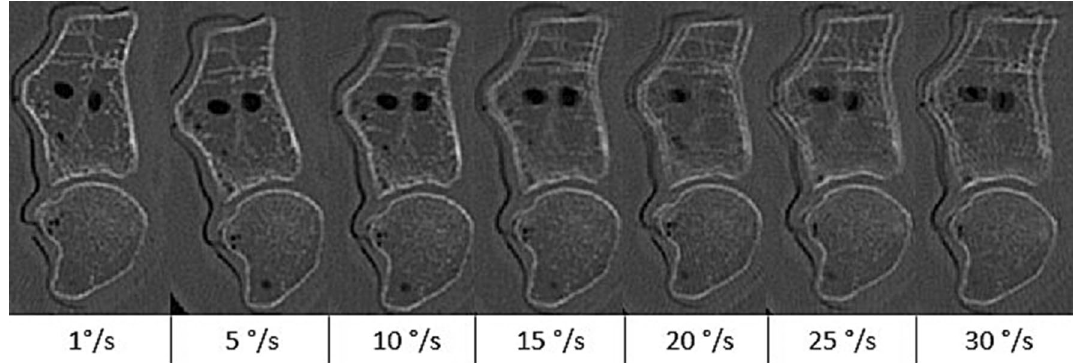
Figure 7. Target frame motion artefacts: CT target images at varying angular velocities. Note the shift from a blurring to a ghosting artefact at speeds greater than ten degrees per